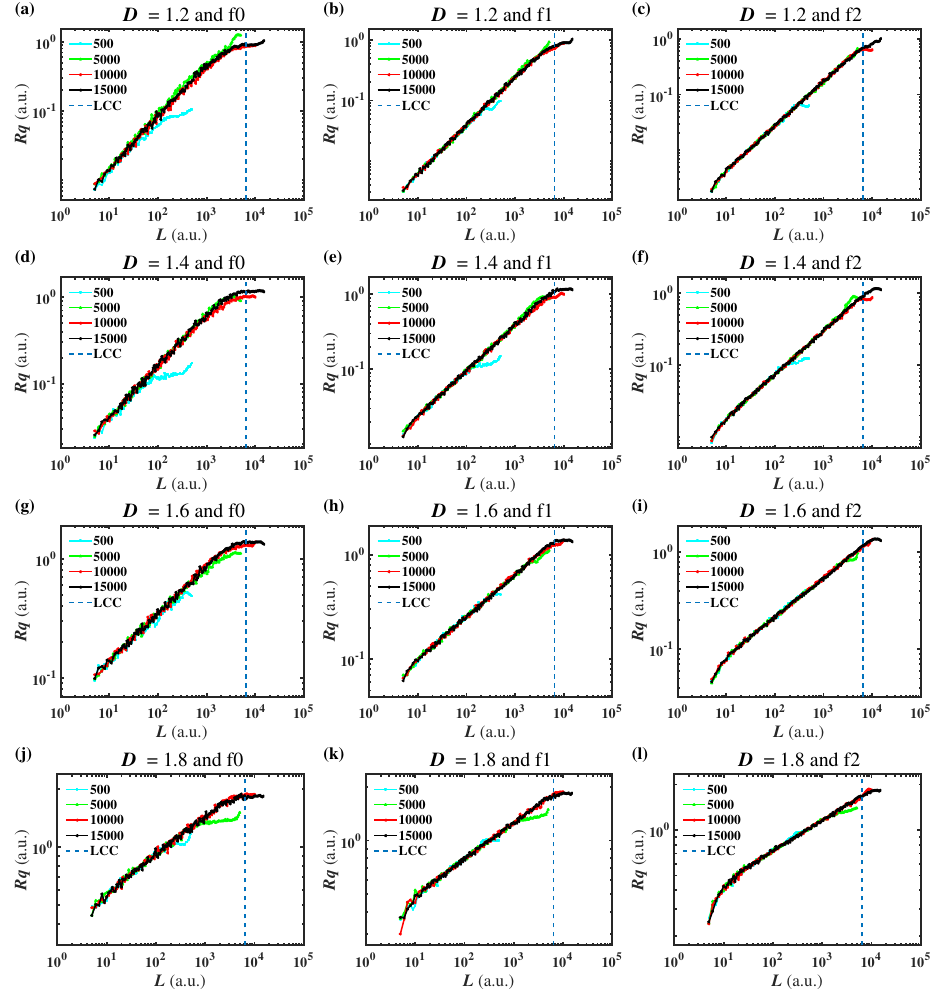
Figure 7. The typical Rq - L curves when the sampling length was 500, 5000, 10,000, 15,000. The flattening order was varied (0, 1 or 2) in the calculation by using the RSE algorithm, and the lower critical condition (LCC, at L = 6434) of the W-M function was denoted as a dashed line for reference. ( a – c ) D = 1.2 with different flattening order and sampling length; ( d – f ) D = 1.4 with different flattening order and sampling length; ( g – i ) D = 1.6 with different flattening order and sampling length; ( j – l ) D = 1.8 with different flattening order and sampling